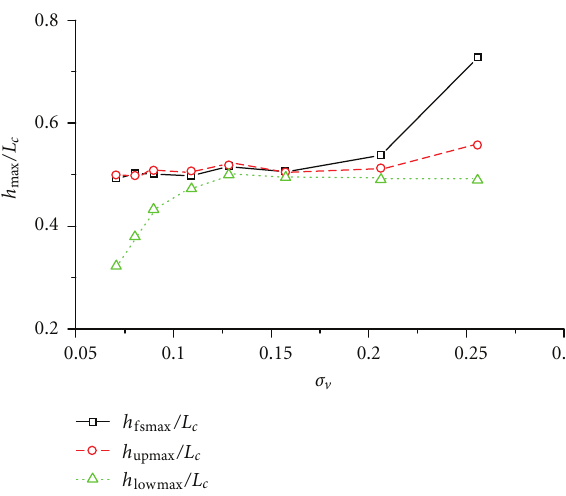
Figure 13: Positions located in the maximal level of the free surface and the maximal width of the cavity surface at di ff erent σ v , h/H = 0 . 25.